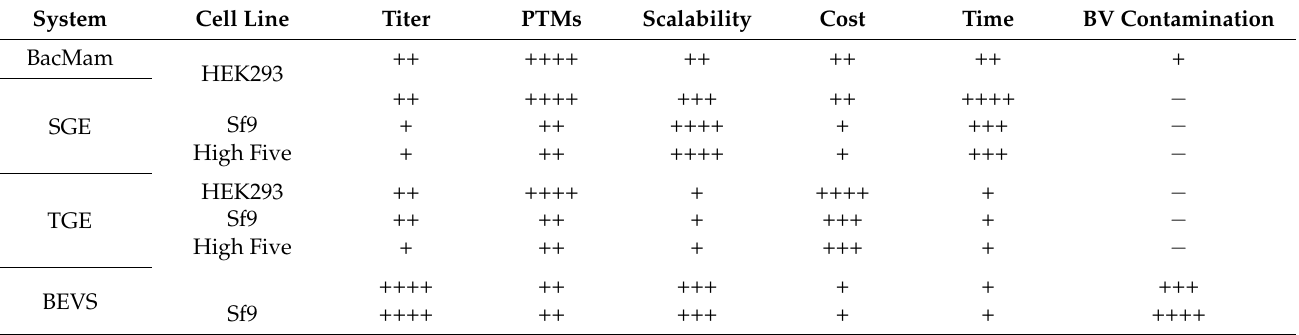
Table 3. Comparison of different platforms employed to produce HIV-1 Gag VLPs. PTMs: